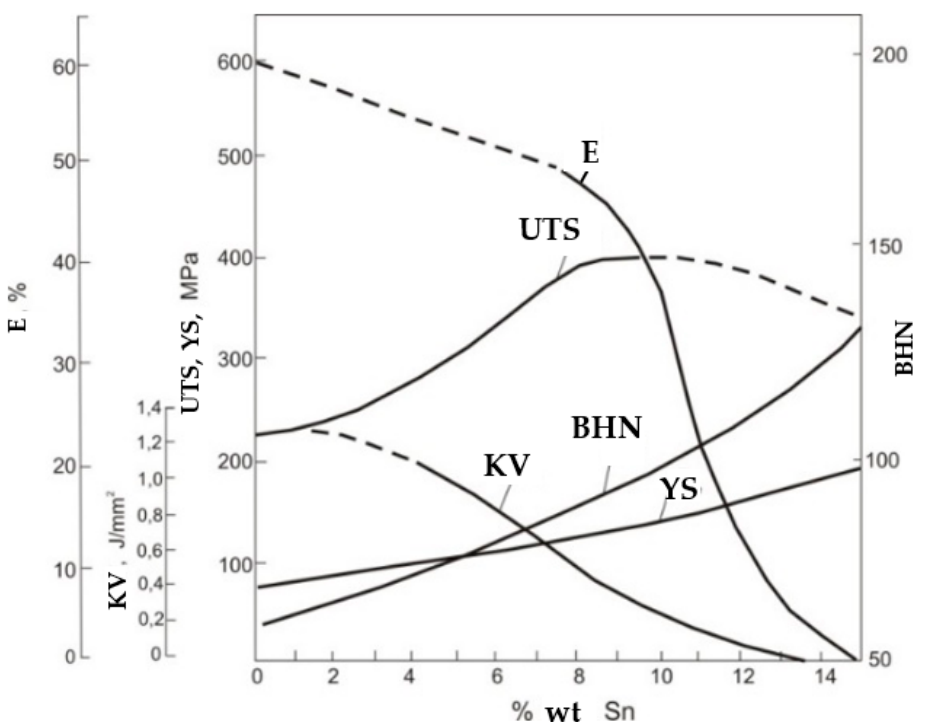
Figure 1. The influence of tin on chosen mechanical properties, the tin bronze hardness change dependent on tin concentration. (E—elongation, UTS—ultimate tensile strength, BHN—Brinell hardness number, KV—impact strength, YS—yield strength) [7].